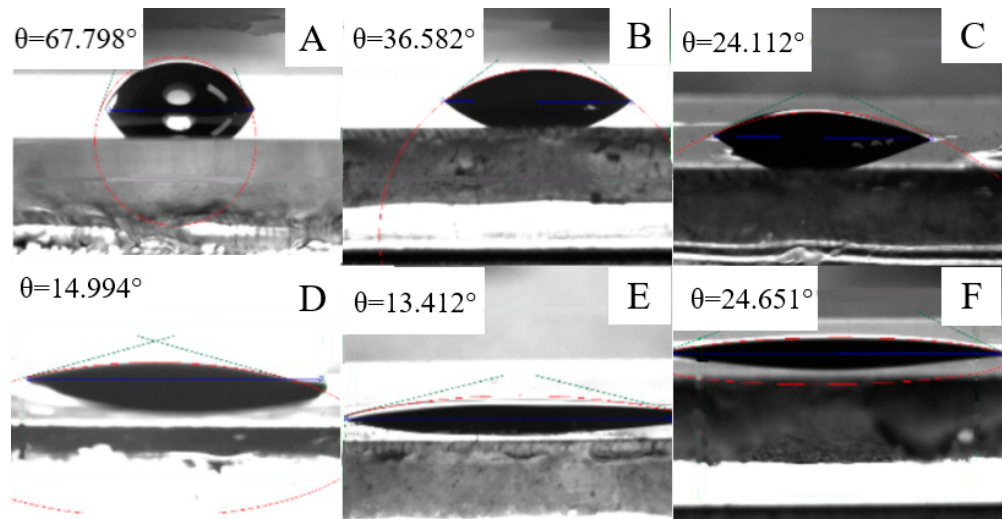
Figure 3. Shows the contact angle of ZnO nanoarrays + Bi 2 O 3 . ( A ) Pure ZnO nanoarrays; ( B ) ZnO nanoarrays + Bi 2 O 3 (10 nm); ( C ) ZnO nanoarrays + Bi 2 O 3 (15 nm); ( D ) ZnO nanoarrays + Bi 2 O 3 (20 nm); ( E ) ZnO nanoarrays + Bi 2 O 3 (25 nm); ( F ) ZnO nanoarrays + Bi 2 O 3 (30 nm).